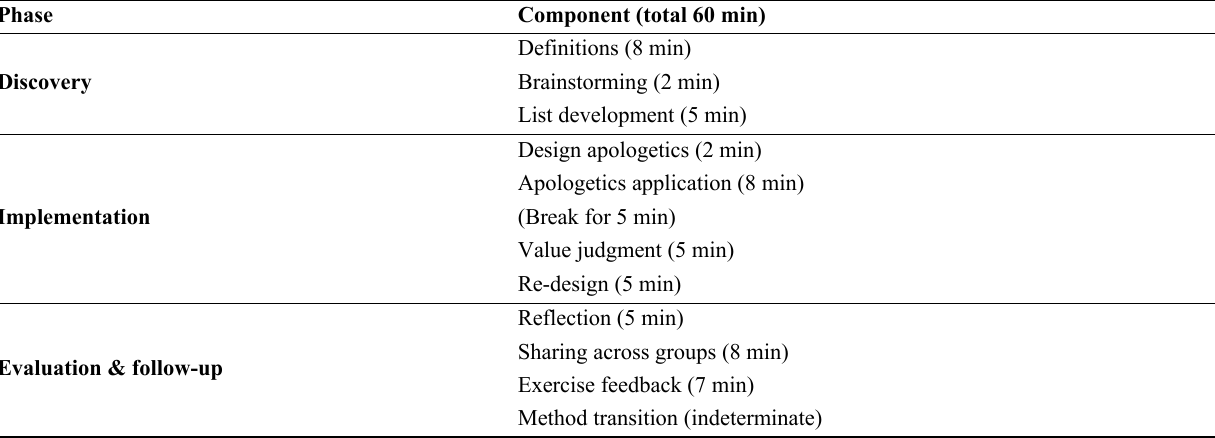
Table 1 Apologos